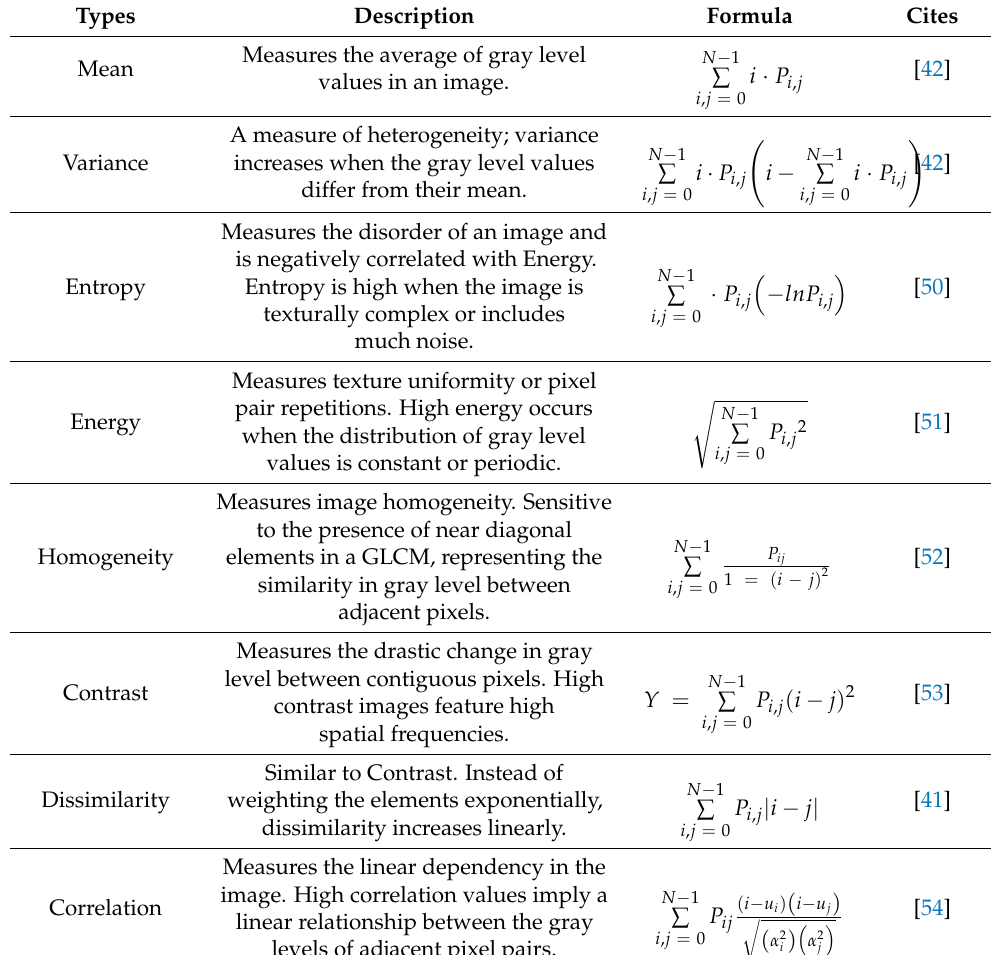
Table 1. Formulas of GLCM